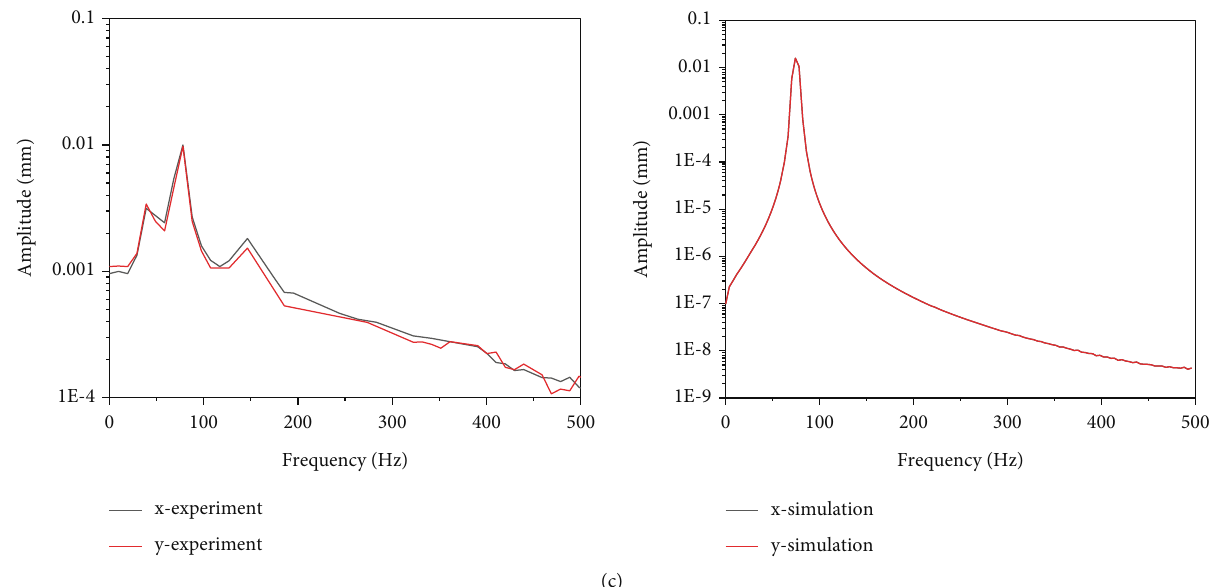
Figure 14: Spectrogram of the shaft for case 1. (a) Subcritical speed. (b) Critical speed. (c) Supercritical